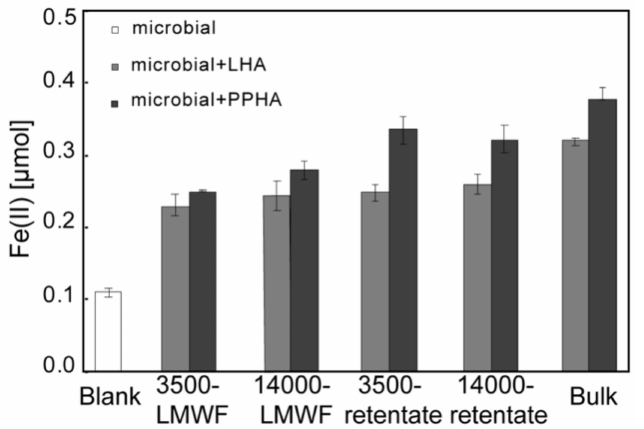
Figure 5. Amount of Fe (II) formation in the microbial ( Shewanella oneidensis MR-1) Fh reduction process in the presence and absence of different molecular weight fractions of LHA and